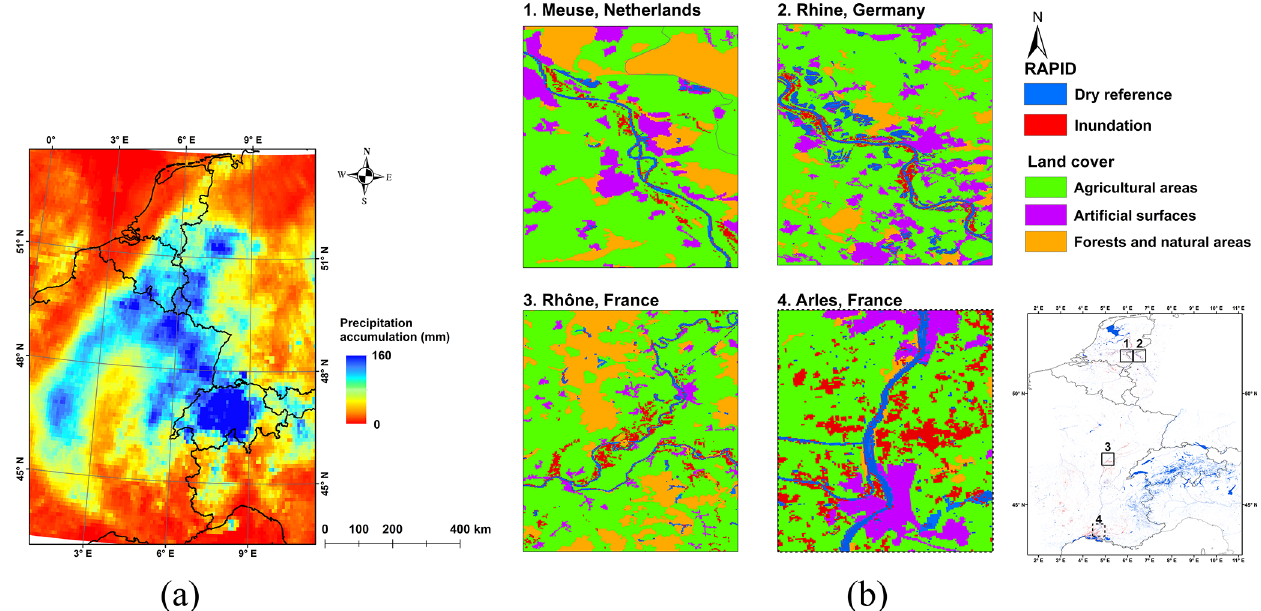
Figure 2. (a) Spatial pattern of precipitation accumulation over western Europe from 12 to 15 July, derived from IMERG half-hourly Final Run data. (b) Inundation extents over western Europe from 15 to 18 July, derived from the RAPID system. Note the inundation results over southeast France, the regions around the dashed rectangle, have uncertainly due to irrigation during the flooding time.